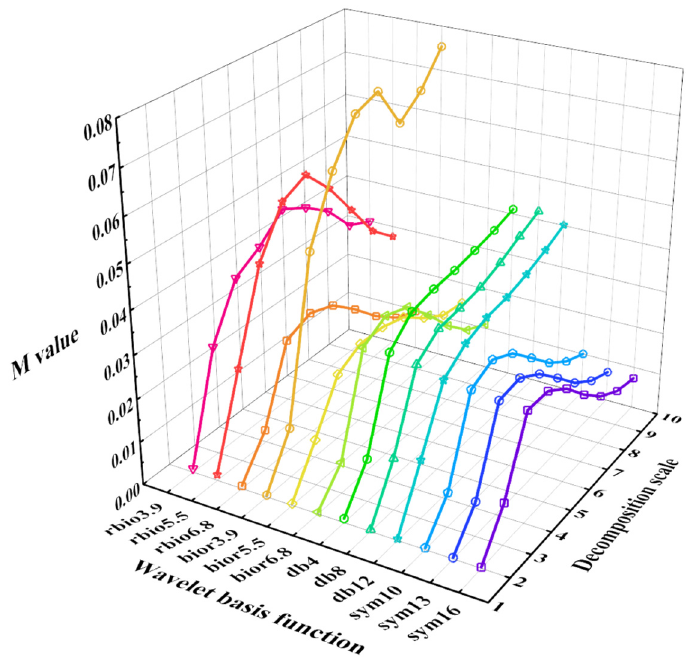
Figure 9. The cost function M value of the basis function to be determined.